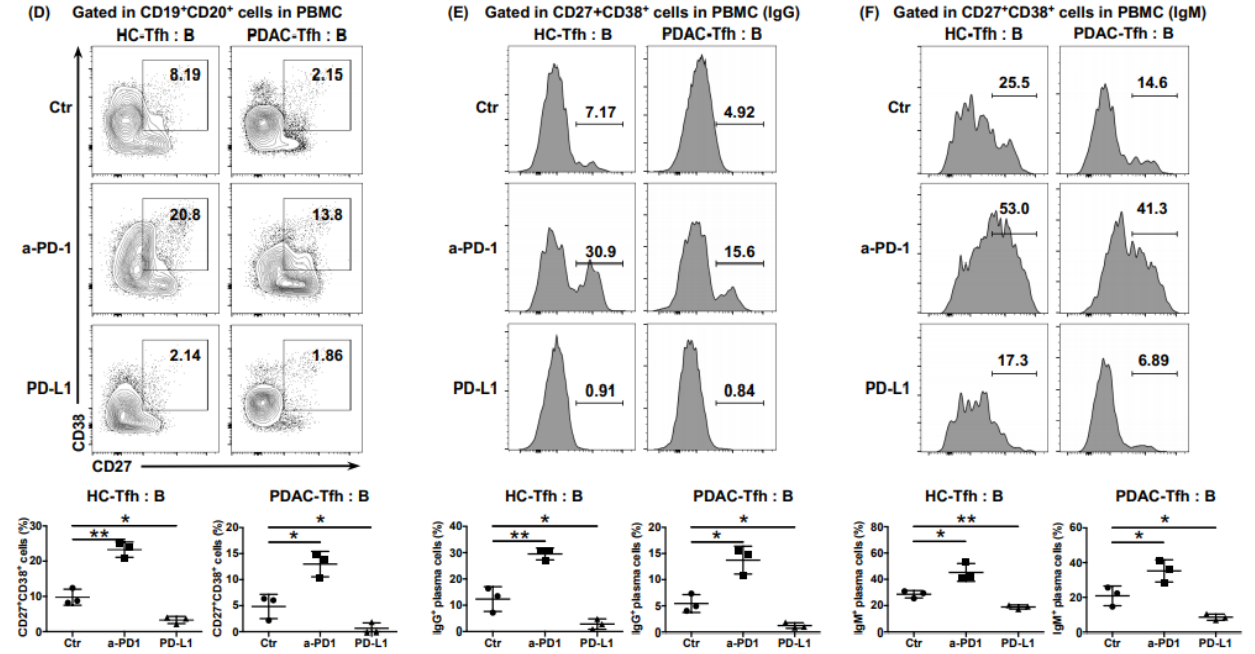
Figure 4. PD-L1/PD-1 signaling inhibits Tfh function and mediates immune escape of PDAC. ( A ) Representative flow cytometry data and the proportion of functional cTfh cells (CD4 + CXCR5 + PD1 + CXCL13 + IL-21 + ) cultured in in vitro with or without anti-PD1 or rhPD-L1 from the peripheral blood of healthy donors ( n = 4) and patients with PDAC ( n = 4). ( B ) Representative flow cytometry data and ( C ) the proportion of CD8 + T cells and B cells recruited to the bottom of the Transwell chamber by cTfh cells, treated with or without anti-PD1 or rhPD-L1 from the peripheral blood of healthy donors ( n = 4) and patients with PDAC ( n = 4). ( D ) Representative flow cytometry data and the proportion of plasma cells (CD27 + CD38 + ) in B cells (CD19 + CD20 + ) co-cultured with cTfh cells, treated with or without anti-PD1 or rhPD-L1 from the peripheral blood of healthy donors ( n = 3) and patients with PDAC ( n = 3). ( E ) Representative flow cytometry data and the proportion of IgG-secreting plasma cells from the cells in ( D ). ( F ) Representative flow cytometry data and the proportion of IgM-secreting plasma cells from the cells in ( D ). Asterisks indicated the significance level of the p -value (* p < 0.05, ** p < 0.01 and *** p < 0.001).